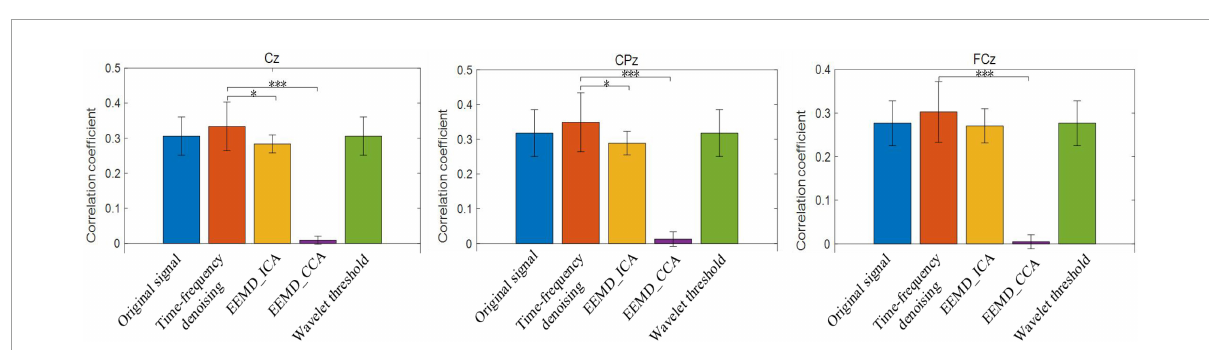
FIGURE7 The average correlation coefficients between the original single trial signal and the reference signal and those between the single trial signal processed by time-frequency denoising, ensemble empirical mode decomposition (EEMD)-ICA, EEMD-canonical correlation analysis (CCA), and wavelet threshold methods and the reference signal. ∗ p < 0.05, ∗∗∗ p <